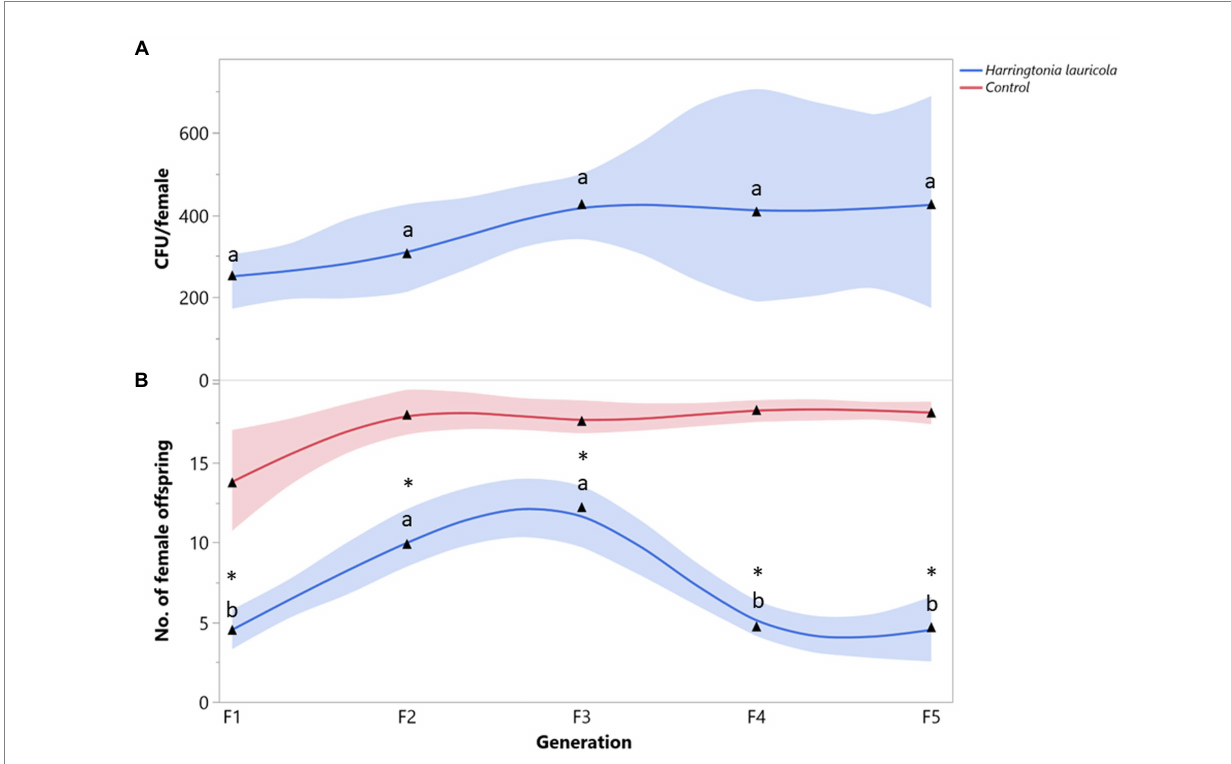
FIGURE 1 Xyleborus bispinatus performance with a single mutualistic fungus ( Harringtonia lauricola ). (A) Mean number of CFUs ( ▲ ) per female offspring per generation and (B) Mean number of female offspring ( ▲ ) produced by single female founder per generation. Same letters within the same color are not significantly different (Tukey HSD, α = 0.05). Asterisks show significant differences in female offspring between fungal symbiont and control within generation (Kruskall-Wallis, α =